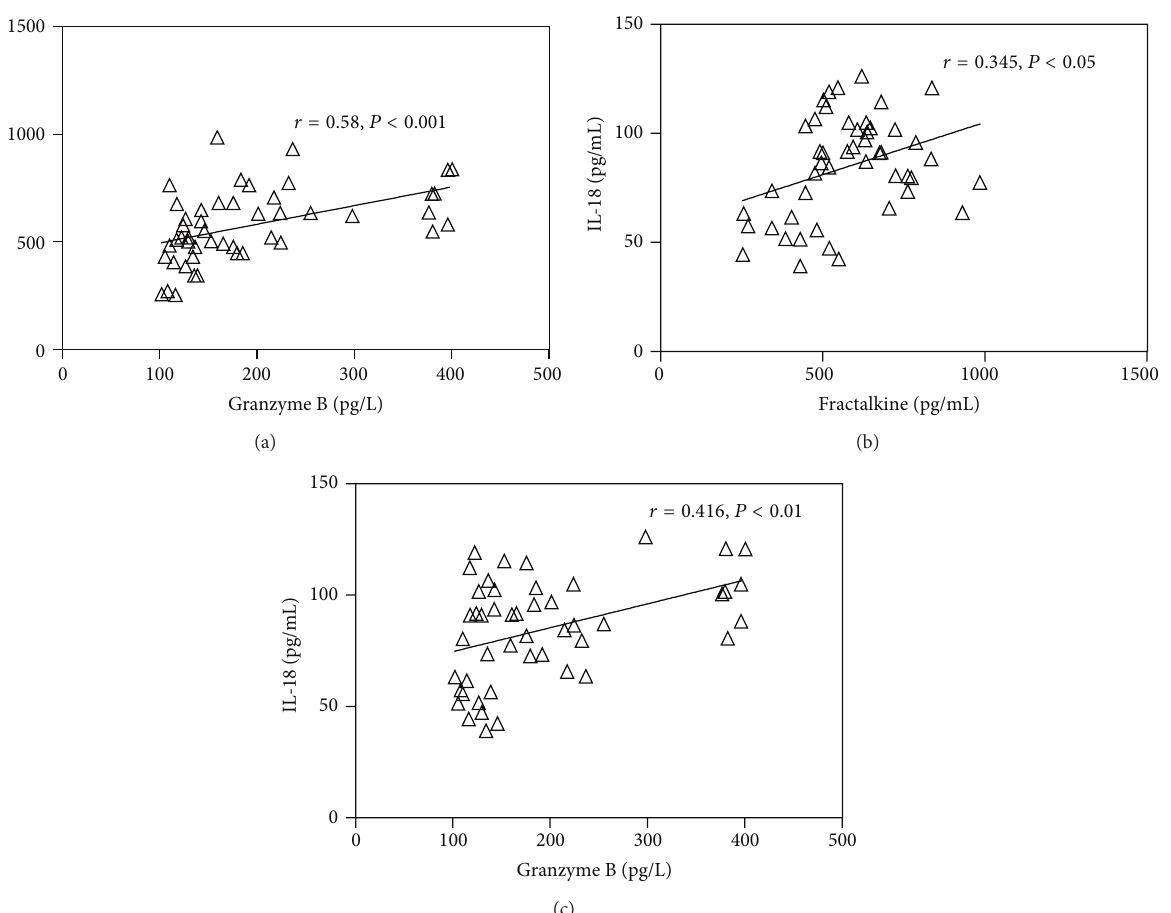
Figure1:(a)Correlationbetweenfractalkine(pg/mL)andgranzymeB(pg/L),(b)correlationbetweenfractalkine(pg/mL)andIL-18(pg/mL), and (c) correlation between granzyme B (pg/L) and IL-18